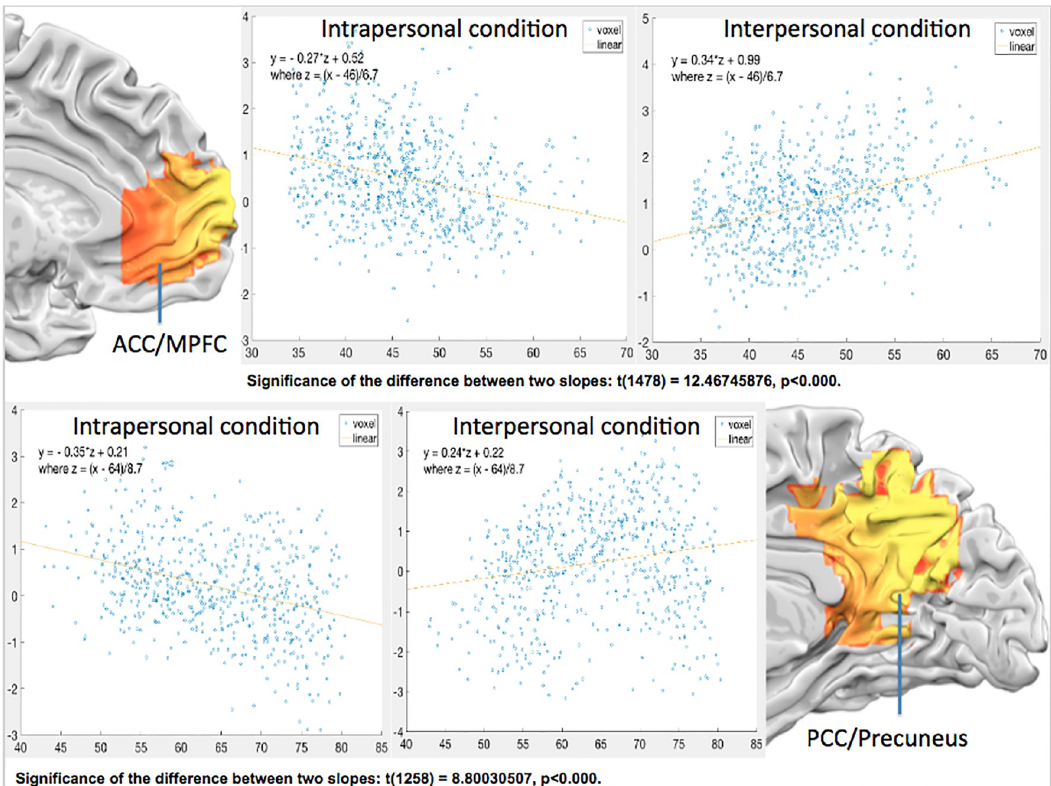
Fig 7. The voxel beta plots of the two core-happiness regions, pACC/MPFC (upper panel) and PCC/precuneus (lower panel), along the rostral-caudal (or y) axis, separately for intrapersonal (left) and for interpersonal (right) wellbeing conditions. The two core regions were delineated via Neurosynth.org, and the numbers for horizontal axis corresponded to y-coordinate value of the activated voxels. The regression lines and equations were provided for visualization and comparison purpose: the voxels in both regions showed decreasing betas in intrapersonal, and increasing betas for interpersonal wellbeing, with increasing distance with AC (Anterior Commissure) point.